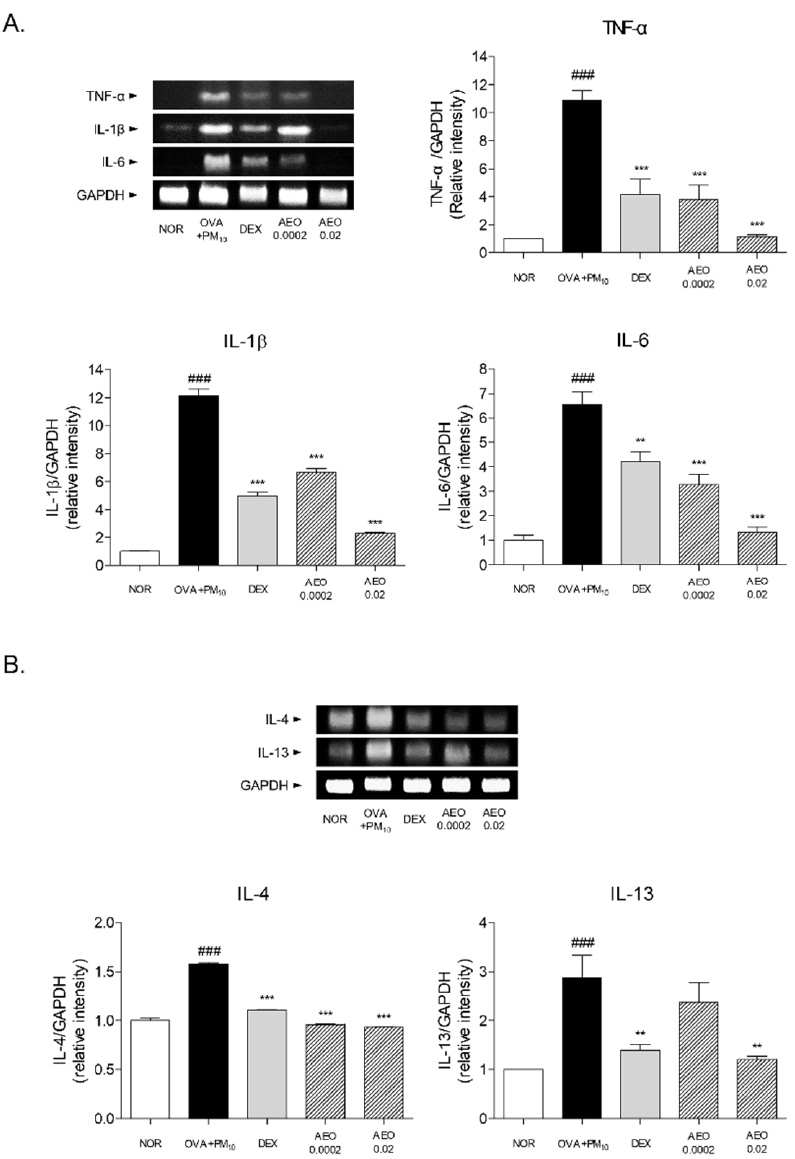
Figure 6. Expressions of pro-inflammatory and Th2-specific cytokines in lung tissues. ( A ) mRNA levels of TNF- α , IL-1 β and IL-6 in lung tissues. Results are presented as mean ± standard error of the mean. ### p < 0.001 vs. NOR group; ** p < 0.01 and *** p < 0.001 vs. OVA+PM 10 group. ( B ) mRNA levels of IL-4 and IL-13 in lung tissues. Results are presented as mean ± standard error of the mean. ### p < 0.001 vs. NOR group; ** p < 0.01 and *** p < 0.001 vs. OVA+PM 10 group.